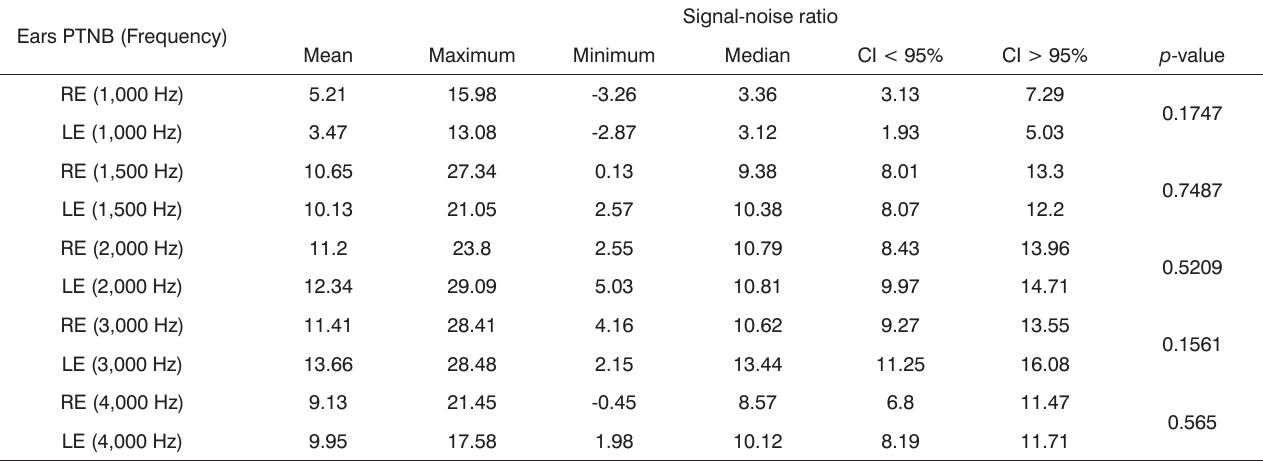
Table 2. Description of the signal-noise ratio variable of TEOAEs (in dB SPL), for each frequency band, in both ears tested of preterm newborns.